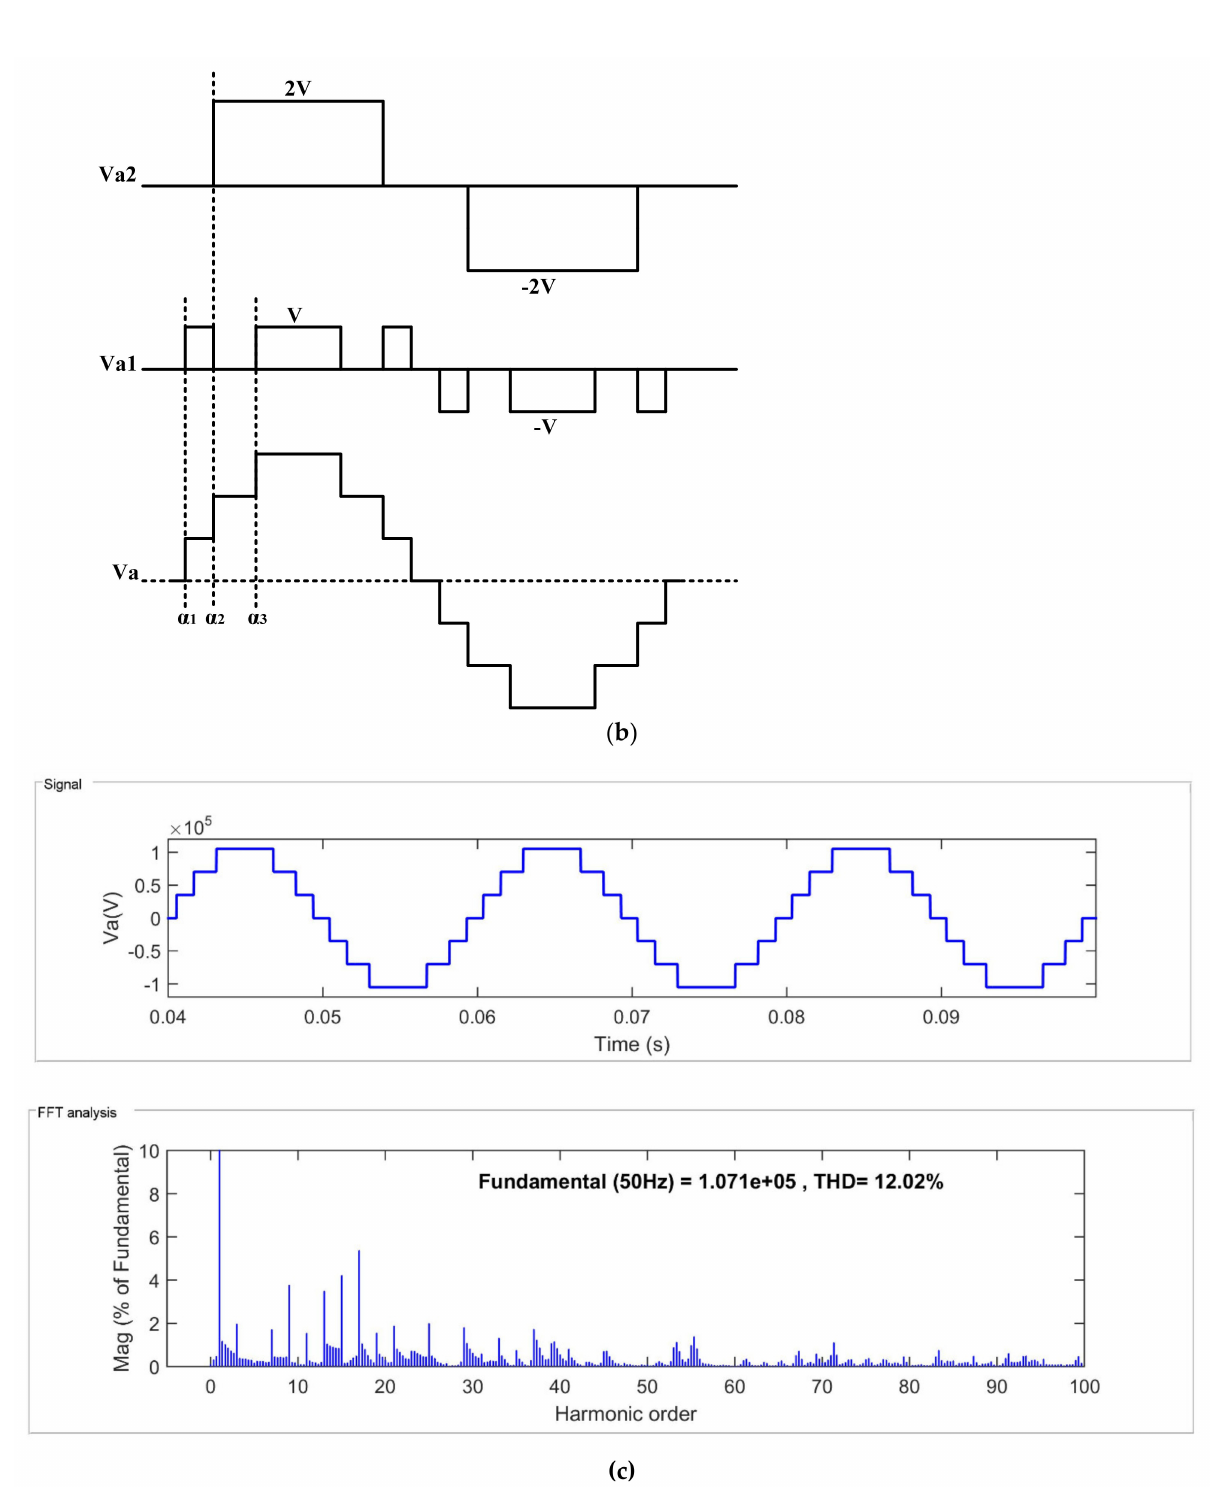
Figure 1. ( a ) STATCOM co2figuration with seven level VSC. ( b ) seven level voltage source converter voltage output waveforms. ( c ) Harmonic spectrum of seven level voltage source converter voltage output